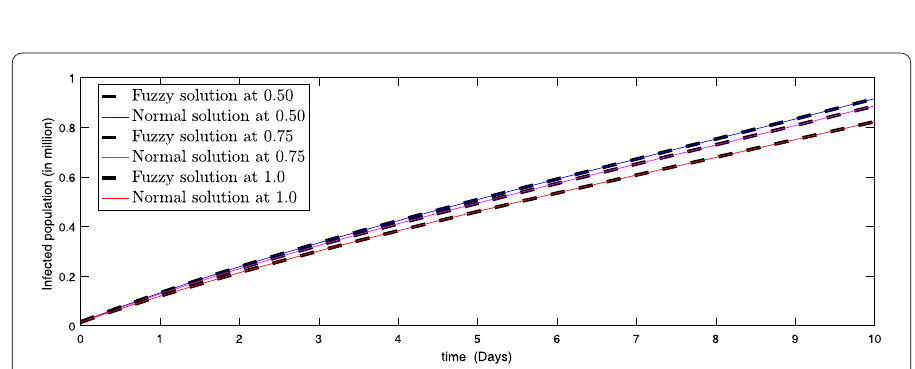
Figure 2 Comparison of approximate fuzzy and normal solution for exposed compartment for three terms at the given uncertainty values α ∈ [0,1] against various fractional order